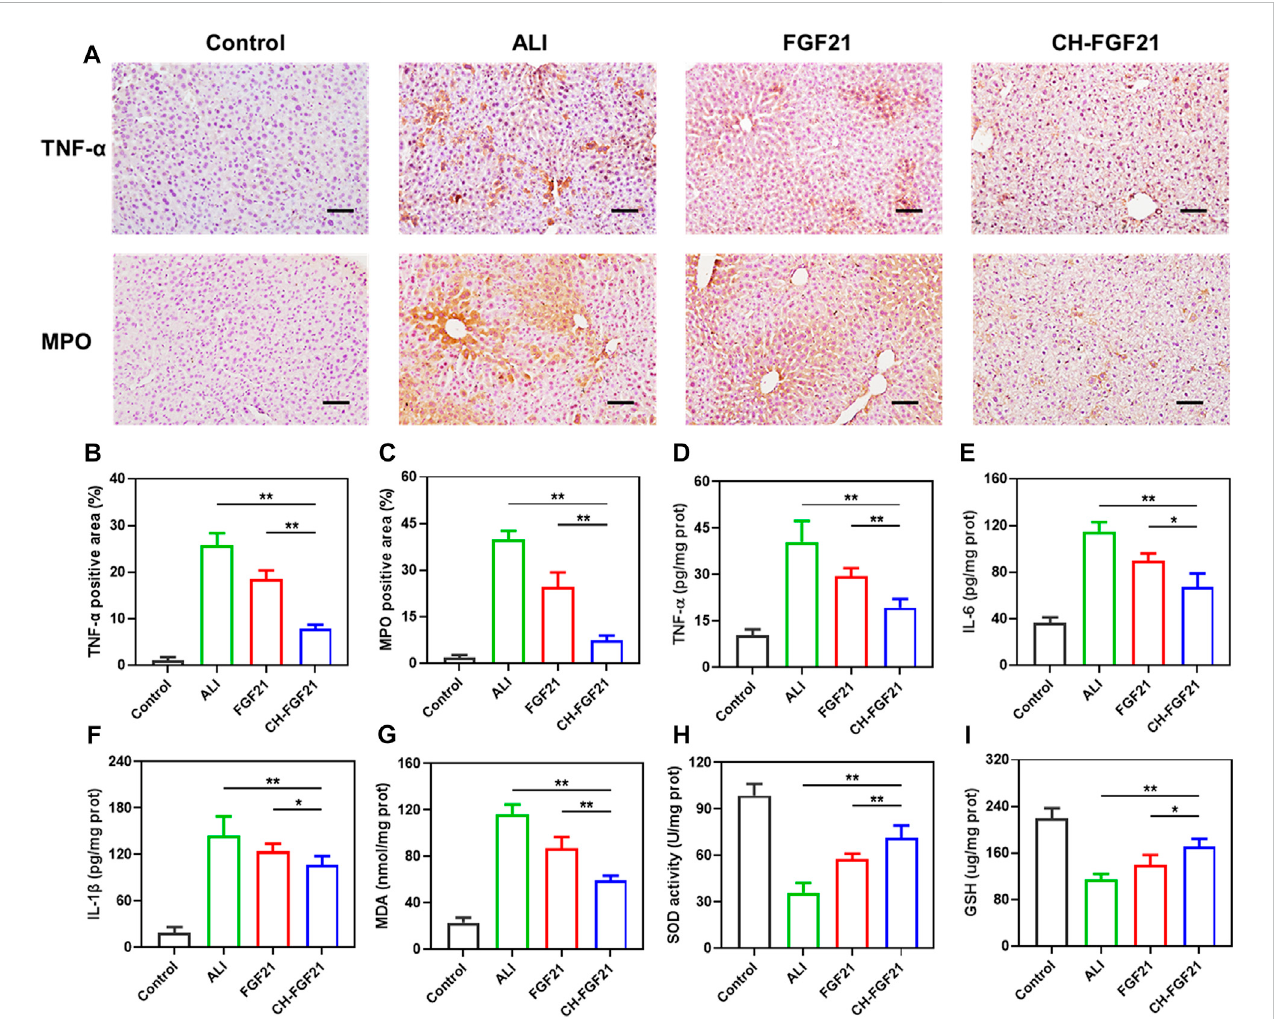
FIGURE 6 Evaluation of in fl ammation and oxidative stress inliver tissues. (A) Immunohistochemical stainingof tumor necrosis factor (TNF)- α andmyeloperoxidase (MPO) in liver tissue. Scale bar = 100 μ m. Quanti fi cation of the positive area of (B) TNF- α and (C) MPO after immunohistochemical staining of liver tissue. Levelsof (D) TNF- α , (E) IL-6, (F) IL-1 β , (G) MDA, (H) SOD,and (I) GSHinthelivertissueofmiceineachgroup.Dataarethemean±SD( n =8).* p ≤ .05,** p ≤